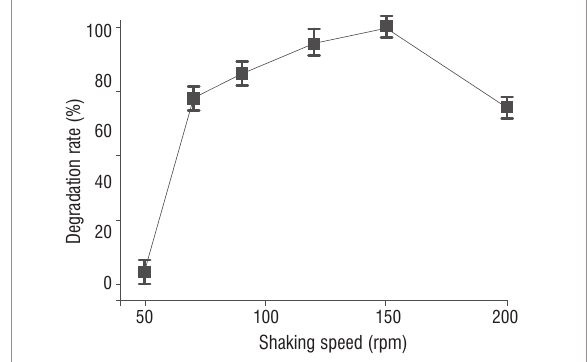
Shaking speed (rpm) Figure 5: Effect of shaking speed on the degradation of terephthalic acid by Arthrobacter sp.0574.